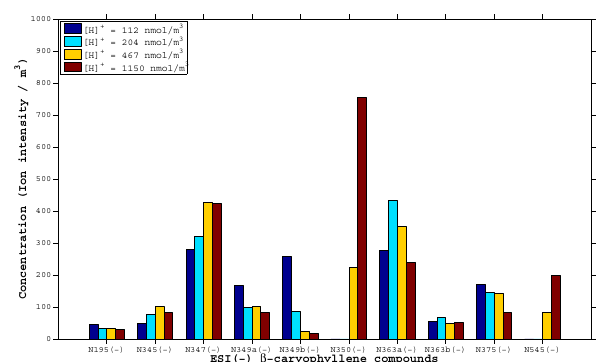
Fig. 4. Concentration of compounds detected by ESI in negative ion mode in the series of β -caryophyllene/NO x irradiation exper- iments (nitrogen-containing compounds). Chemical formulas and proposed chemical structures of these compounds are given in Ta- ble 4.